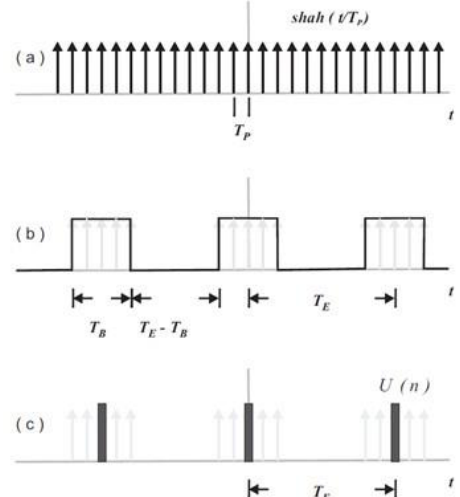
Figure 2. Ensemble averaging obtained by: ( a ) uniform sampling; ( b ) time windowing; and ( c ) ensemble value calculated during period T B resulting in low-pass filtering.